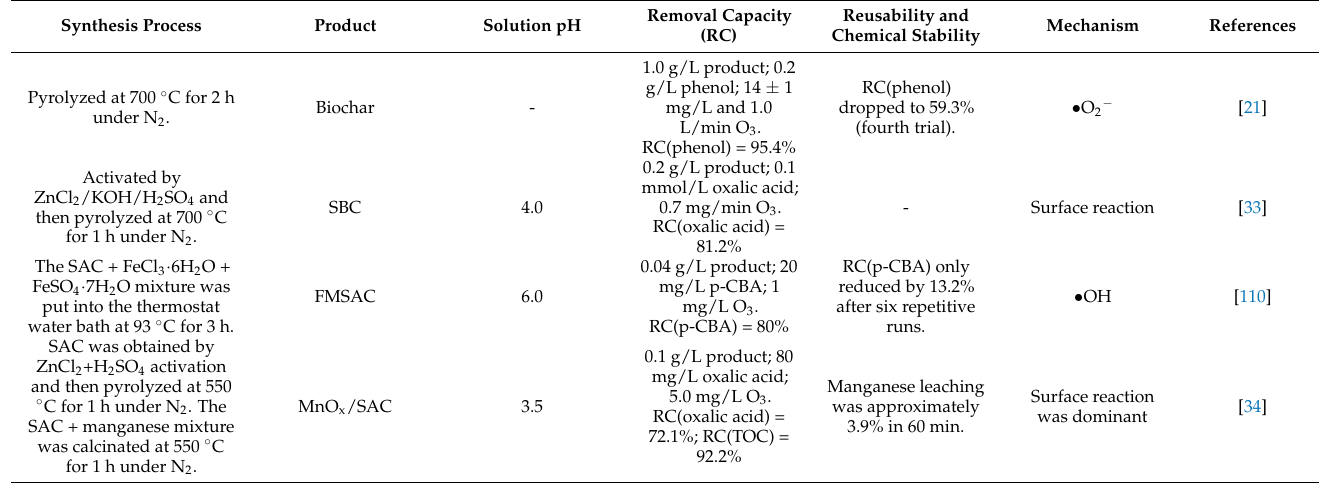
Table 5. Application of sludge-based catalysts in